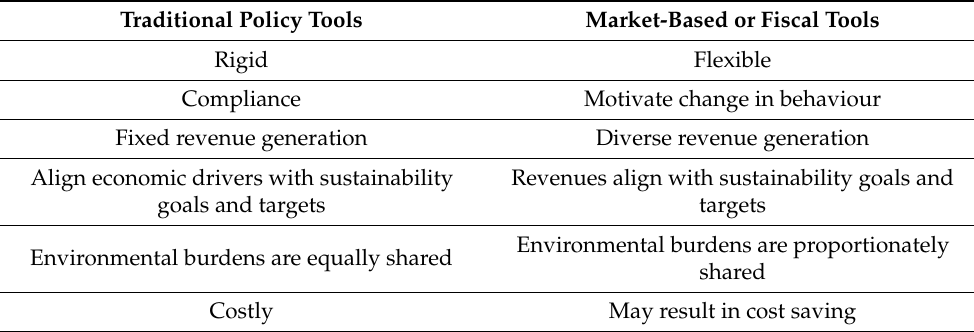
Table 2. Summary of Traditional versus Fiscal Policy